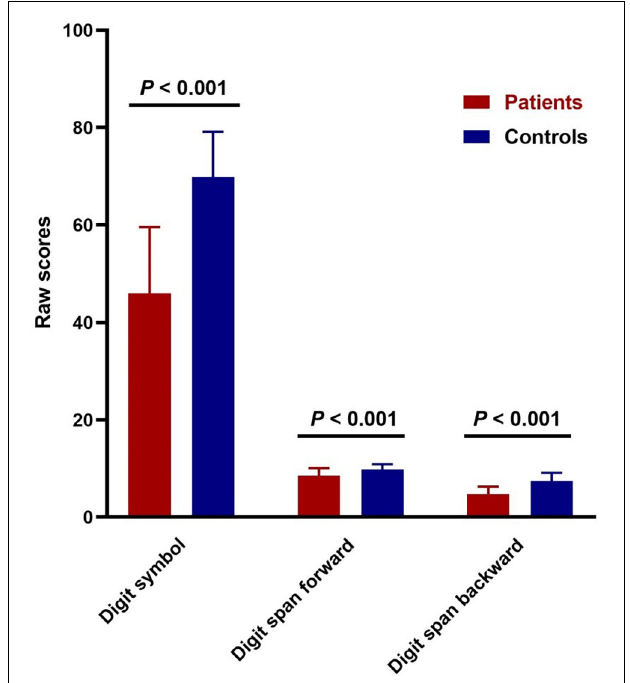
FIGURE 1 | Cognitive impairments in patients with schizophrenia. Comparison of digit symbol coding test ( t = –13.985, p = 3.503E-29) and digit span raw scores (forward: t = –5.745, p = 4.7247E-8; backward: t = –10.225, p = 9.7559E-20) between patients and